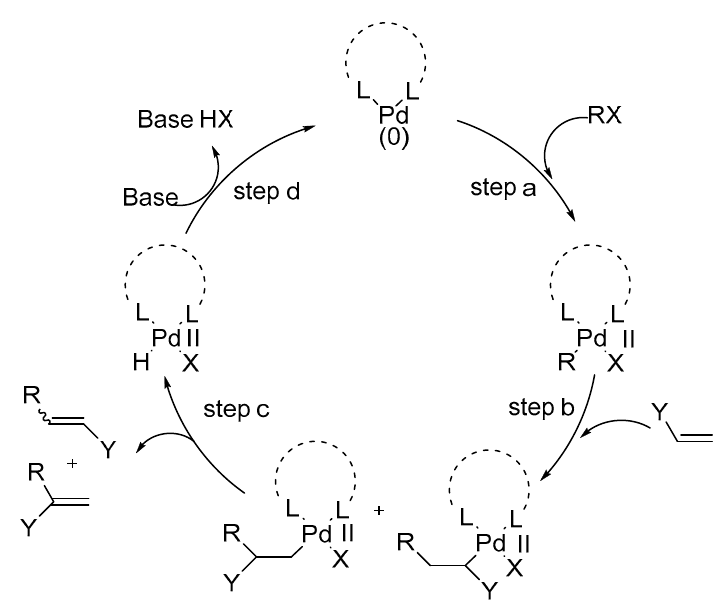
Scheme 5. Mechanism based on Pd(0)/Pd(II) cycle by Cabri and Candiani [66].